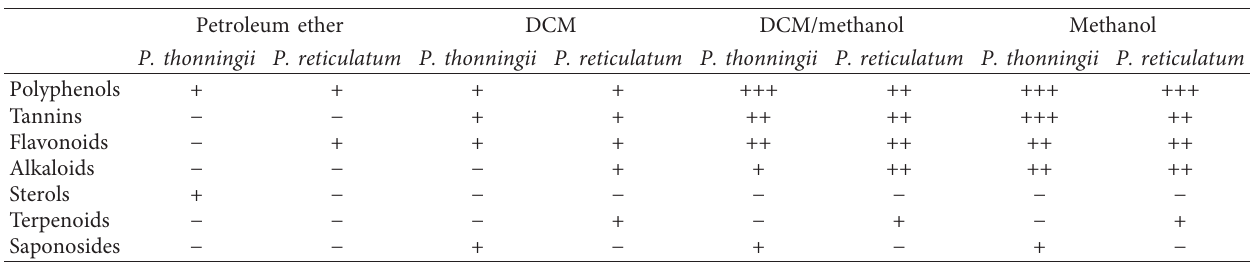
Figure 1: Extraction yields of both plants by different solvents. Statistically, the difference in yields between the two plants for each solvent is not significant ( p � 0 . 45 > 0 . 05). Table 1: Results of phytochemical screening of the composition of Piliostigma reticulatum and Piliostigma thonningii leaves.